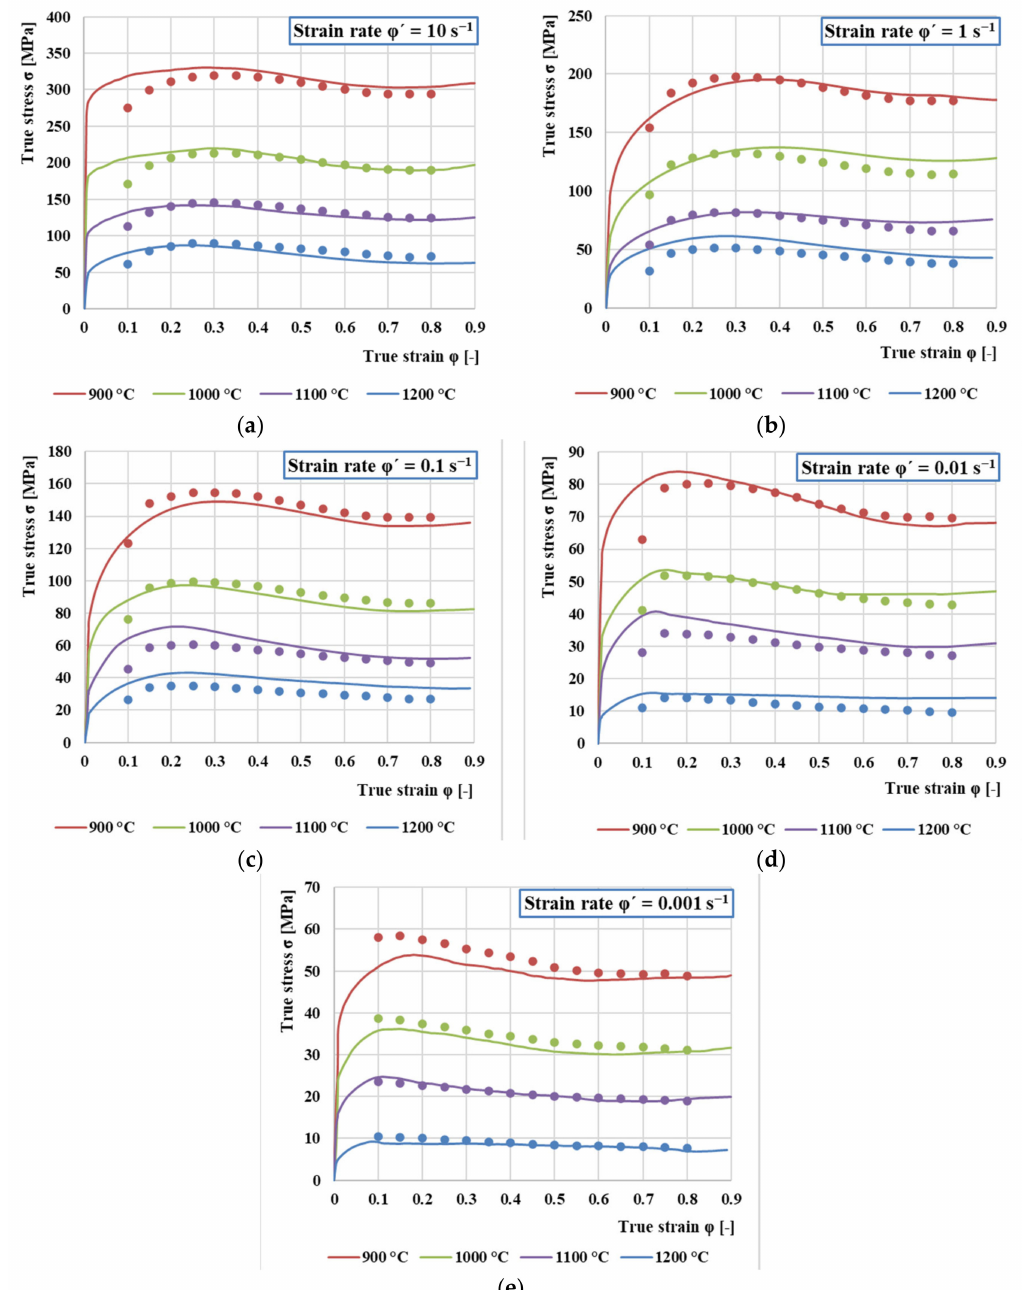
Figure 12. True Stress–True Strain Diagrams with measured (lines) and predicted (dots) flow stresses for ( a ) strain rate ϕ ’ = 10 s − 1 ; ( b ) strain rate ϕ ’ = 1 s − 1 ; ( c ) ϕ ’ = 0.1 s − 1 ; ( d ) ϕ ’ = 0.01 s − 1 ; ( e ) ϕ ’ = 0.001 s − 1